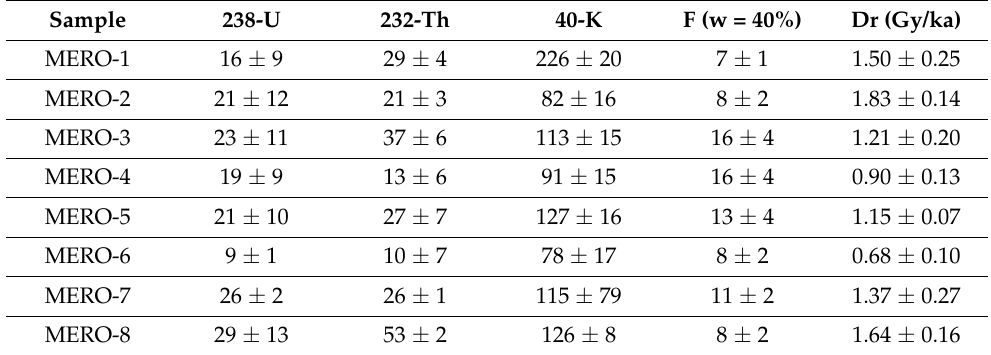
Table 1. Radioisotopic activity (Bq/kg) from 238 uranium, 232 thorium and 40 potassium. Dose-rate ( D r ) and saturation fraction (F) from water content (w = 40 ± 4%) following [20].